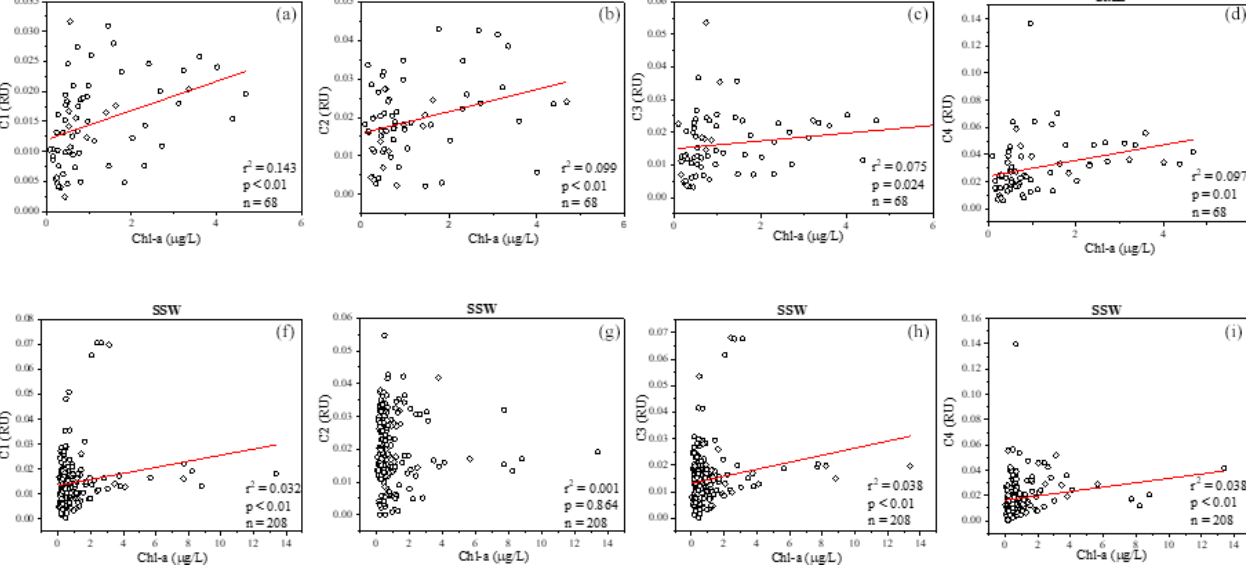
Figure 4. Relationships between a (254), four fluorescence components and Chl a in the sea-surface microlayer (SML) (a–d) and in the SSW (f–i) . Table 1. Spectral characteristics of the four fluorescent components identified by the PARAFAC modal in this study compared with those preciously